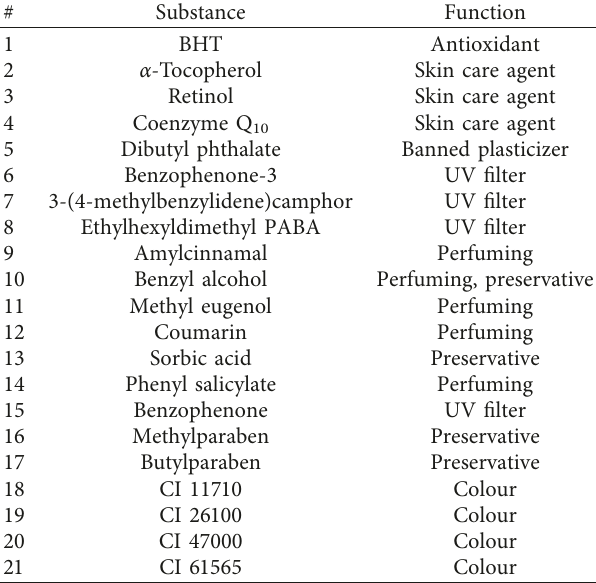
Table 2: Test compounds for the TLC